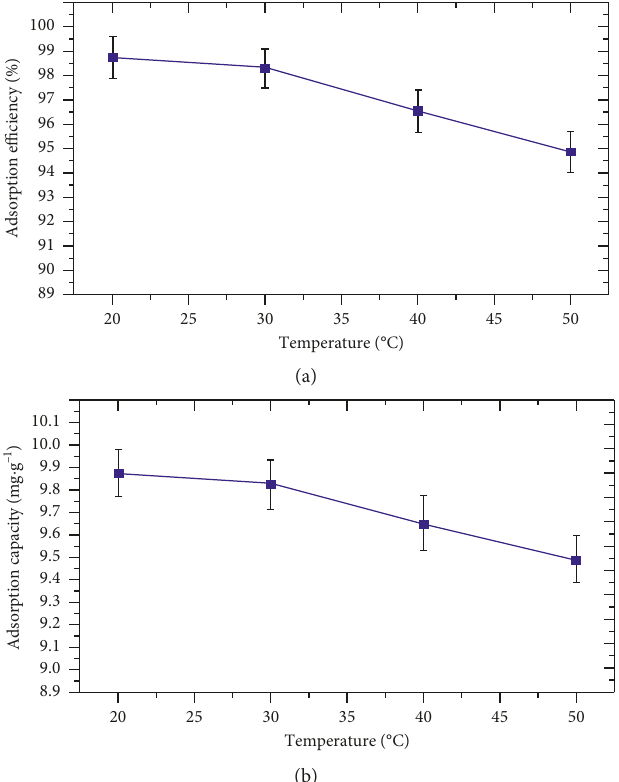
Figure 7: Effect of temperature on (a) adsorption efficiency and (b) adsorption capacity. m � 2 g · L − 1 ; [DM] � 20mg · L − 1 ; T � 20–50 ° C; pH � 6; V ag � 400rpm; t �